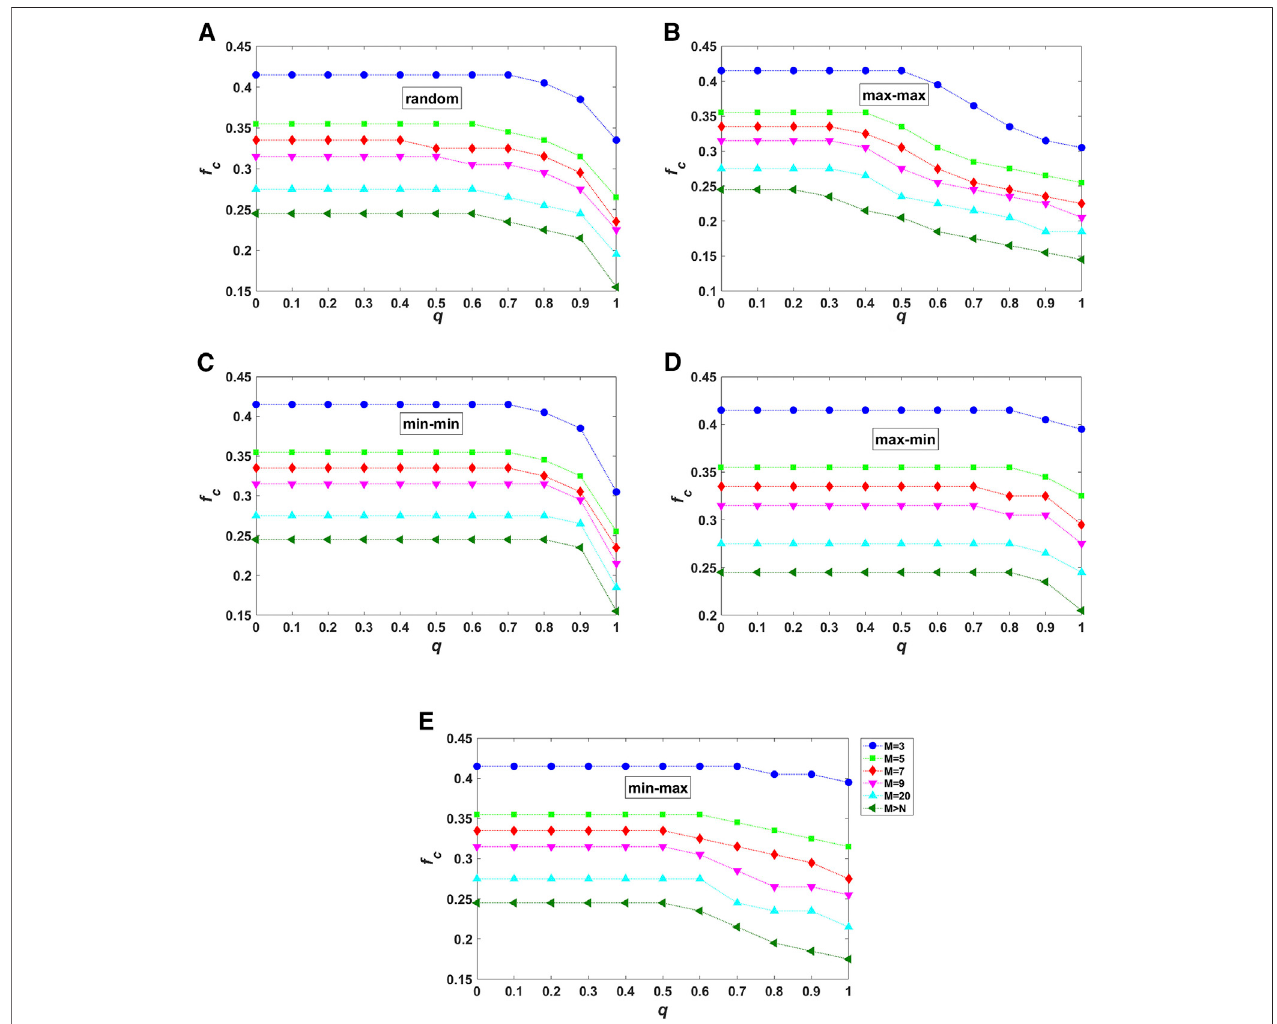
FIGURE 6 | (Color online) Vulnerability analysis of partially interdependent local-world networks after cascading failures caused by intentional removal of high- degreenodesfromonenetwork.Bothinterdependencepreferenceandstrengthareconsidered: (A) random ; (B) max – max ; (C) min – min ; (D) max – min ; (E) min – max .All the plots show the joint effect of interdependence strength q and local world size M on the critical threshold values of f c . f c is the minimum fraction ofnodes that must be removed to trigger the avalanche of the entire system. At f (cid:2) f c , the whole network is nearly destroyed with the relative size of the largest connected components S ≈ 0andtheresidualcommunicationef fi ciency η ≈ 0.Asmaller f c indicatesthatcorrespondingnetworksaremorefragileagainstattacksand viceversa .Theresultsare obtained by averaging over 50 independent realizations on interdependent systems consisting two local-world networks, which are separately constructed with N (cid:2) 2000, m (cid:2) 3, and 〈 k 〉 (cid:2) 2 m (cid:2) 6 for different M ( M (cid:2) 3 , 5 , 7 , 9 , 20 and M > N